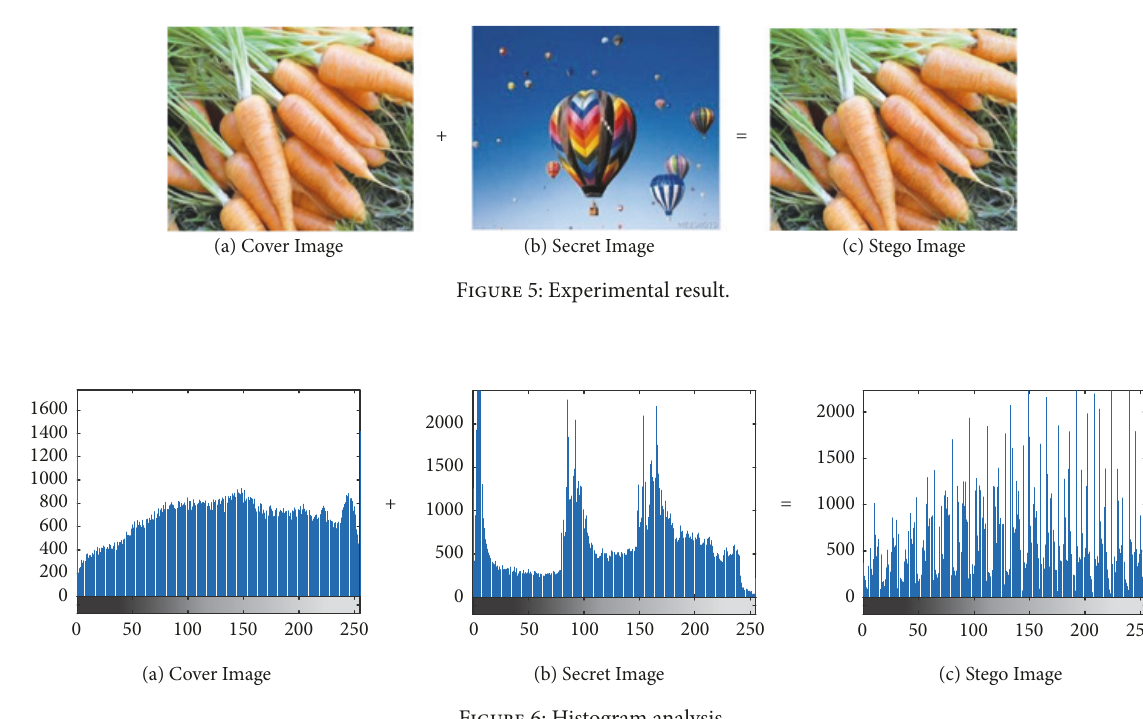
Figure 6: Histogram analysis.